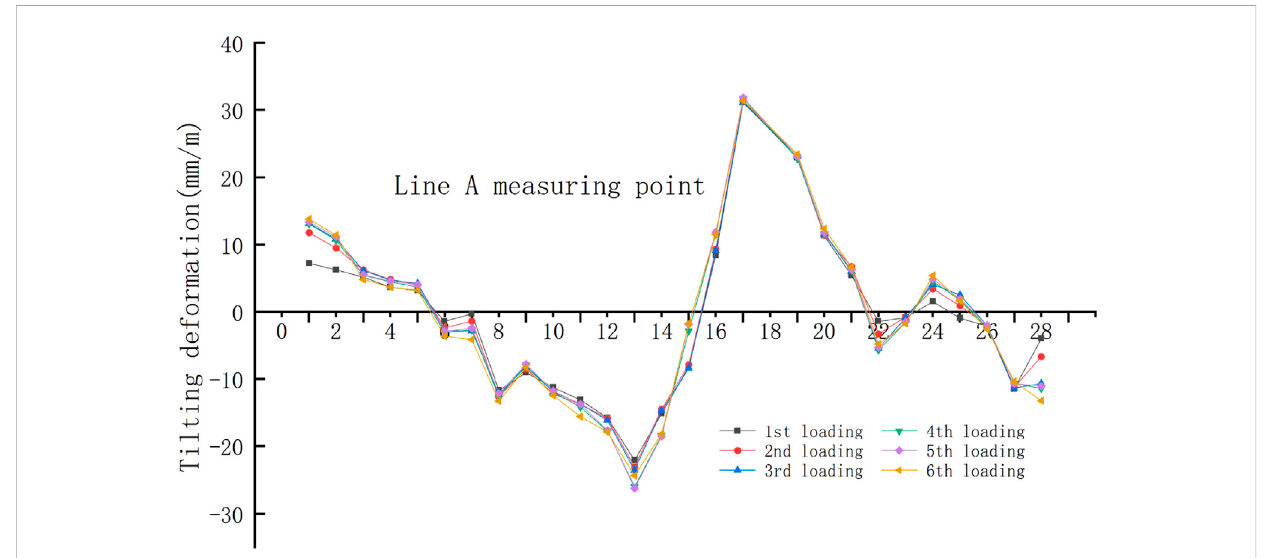
FIGURE 11 Surface curvature deformation change curve after